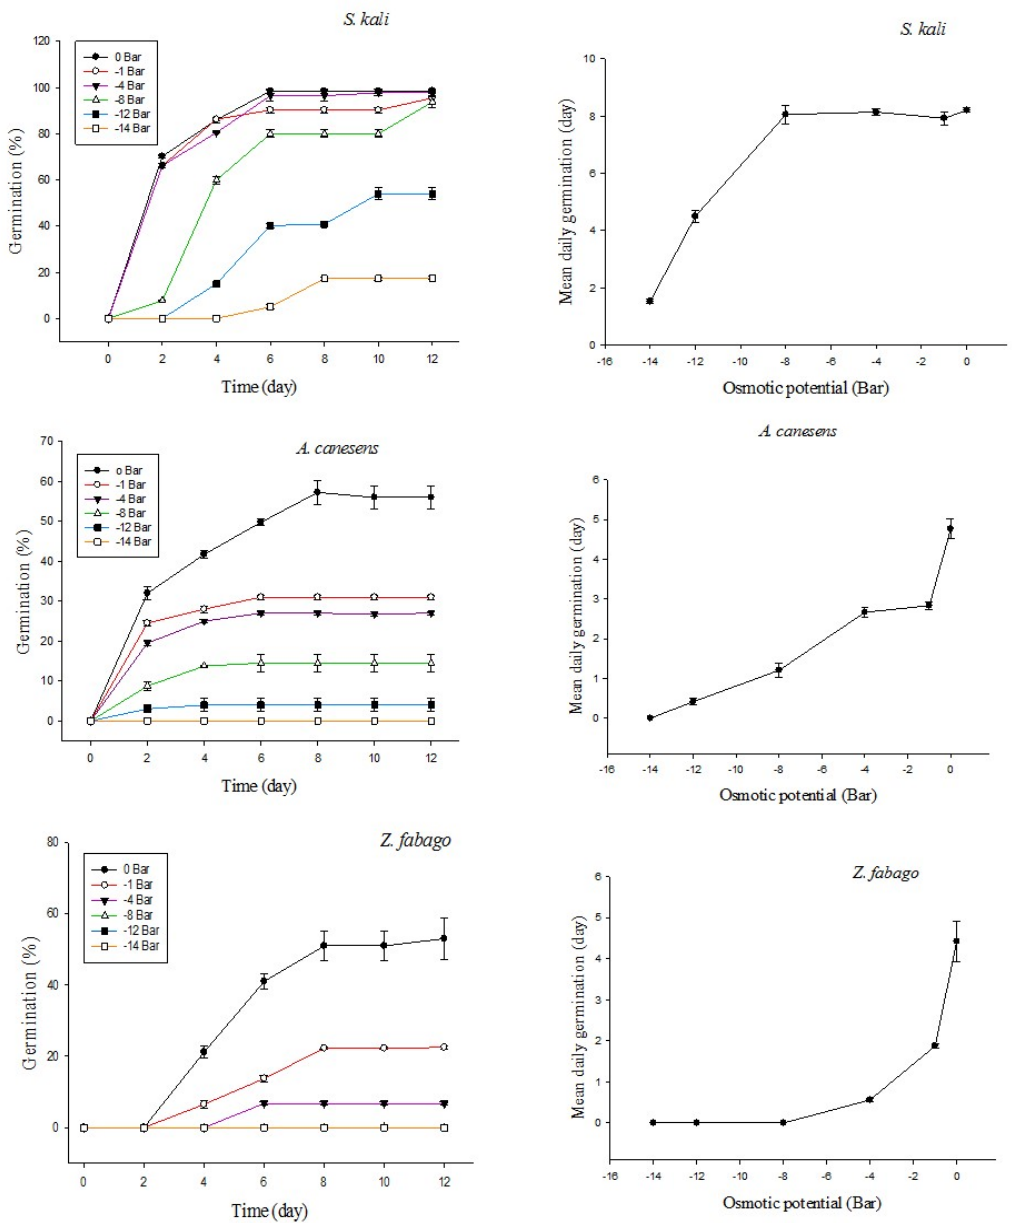
Figure 1. Germination (%) of S. kali , A. canescens and Z. fabago under di ff erent polyethylene glycol (PEG-6000) concentrations at di ff erent times ( left ) and mean daily germination of S. kali , A. canescens and Z. fabago under di ff erent PEG-6000 concentrations ( right ). Data represent means ( n = 4) ± SE.